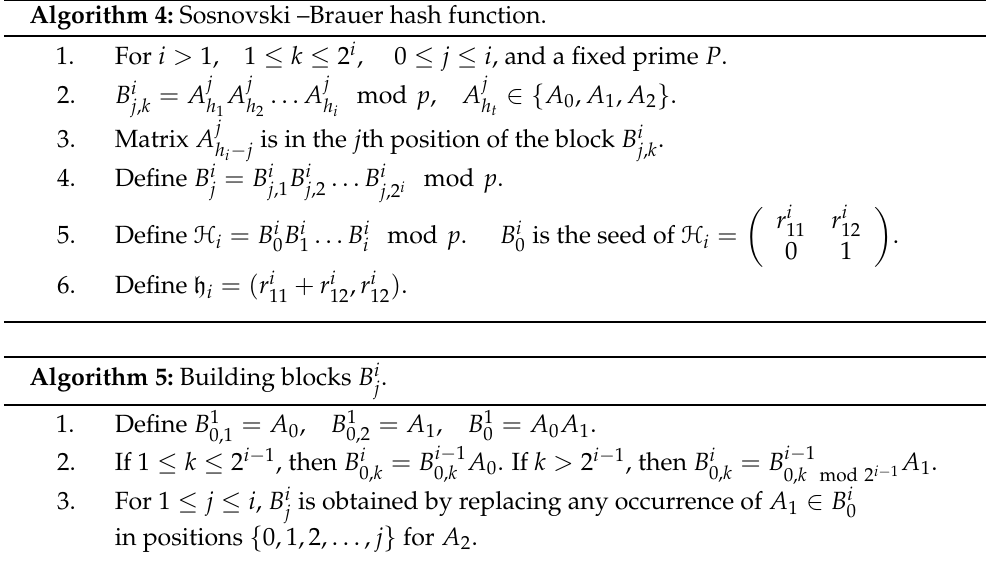
Table 2. Matrices H i , 1